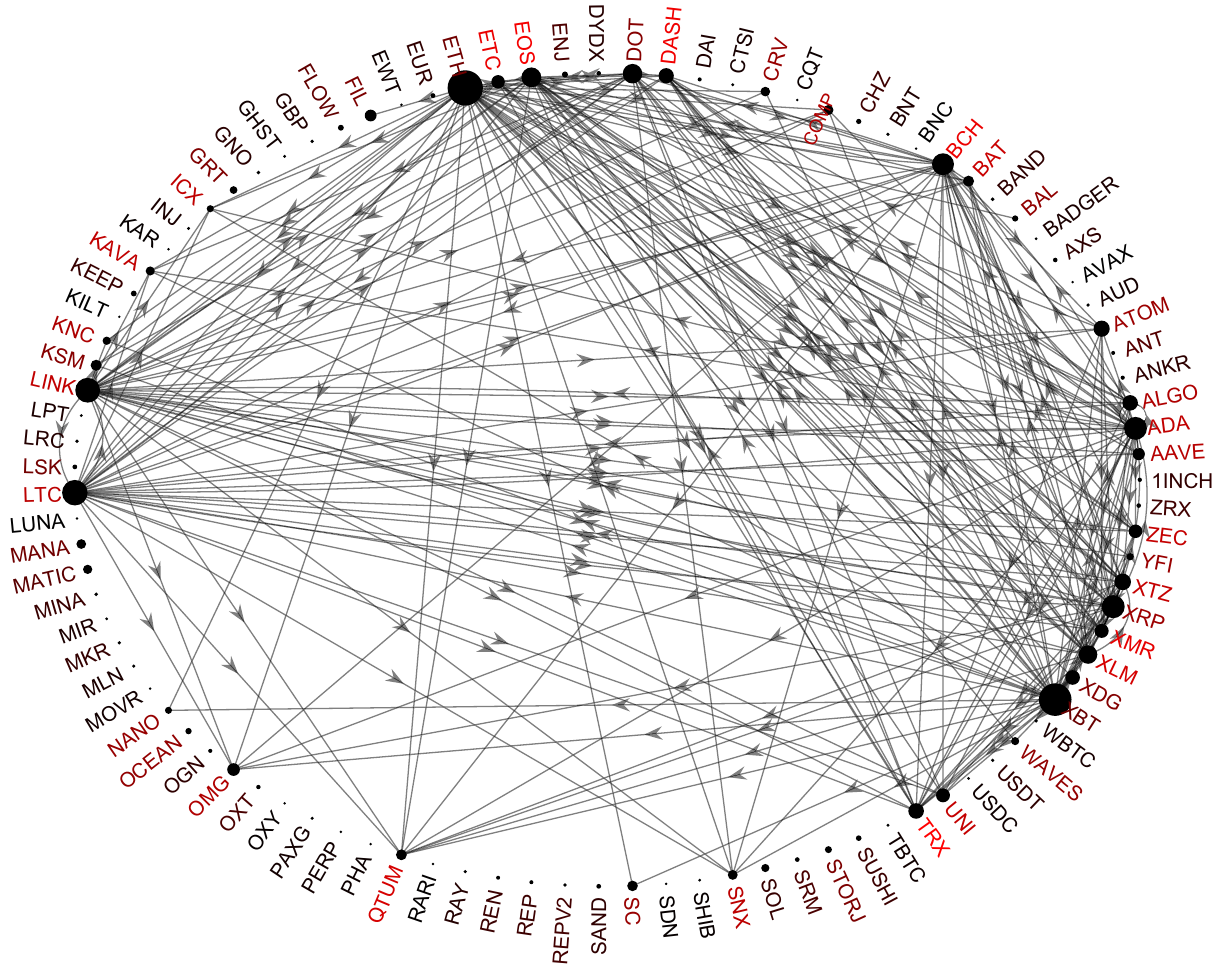
Figure 1. The average USD network of pairwise Granger causality. Each link a ij represents the Granger causality averaged over the 104 weekly windows from 28 Dec, 2019 to 30 Dec, 2021. The size of the nodes represents the total out strength k out i = (cid:31) j a ij , while the label color (from black to red) is the total in strength = (cid:31) k in a ij , that is how much that node is influenced by the rest of the network. A comprehensive list of the i j most influential and influenced nodes is plotted in Figure 2, where the total out strength and in strength values are shown for each